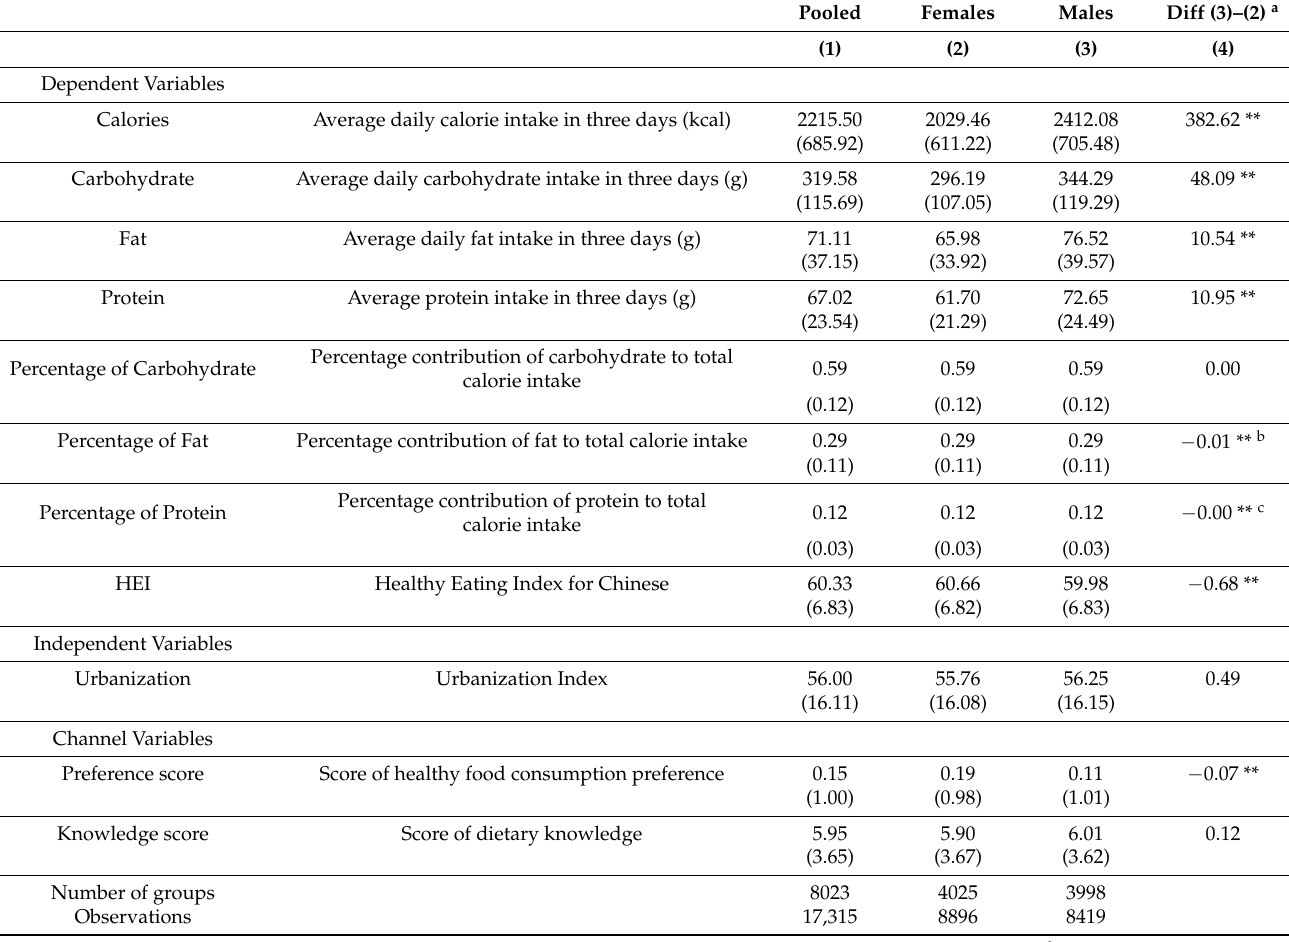
Table 1. Descriptive statistics of the main